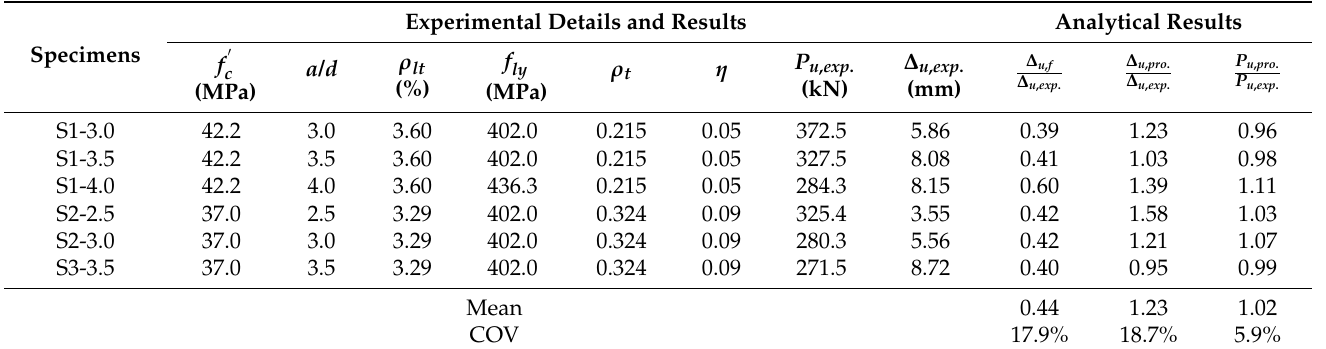
Figure 6. Details of typical specimens (unit: mm): ( a ) S1 series (S1-3.5); ( b ) S2 series (S2-3.5). Table 3. Details of specimens and experimental and analytical results.